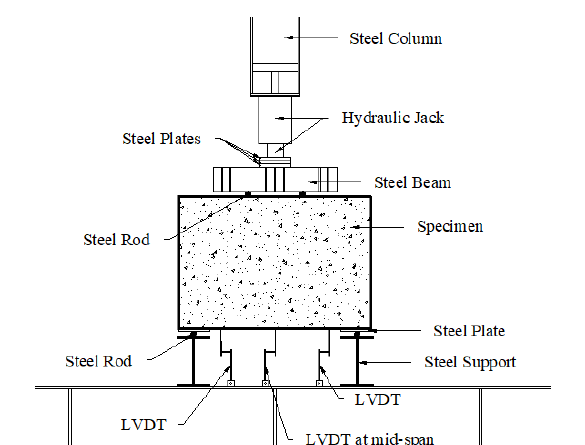
Figure 3: Details of the experimental